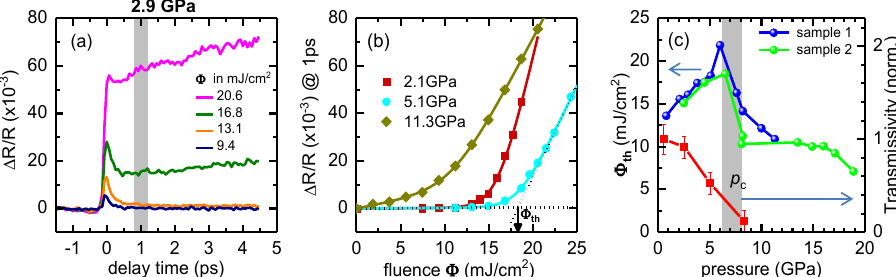
Fig. 1. (a) Normalized pump-probe signals measured at a pressure of 2.9 GPa for different excitation fluences  ; (b) Fluence dependence of pump-probe signals averaged around the delay time of 1 ps; (c) Pressure dependence of the threshold fluence  th (blue and green) and the normalized THz transmissivity